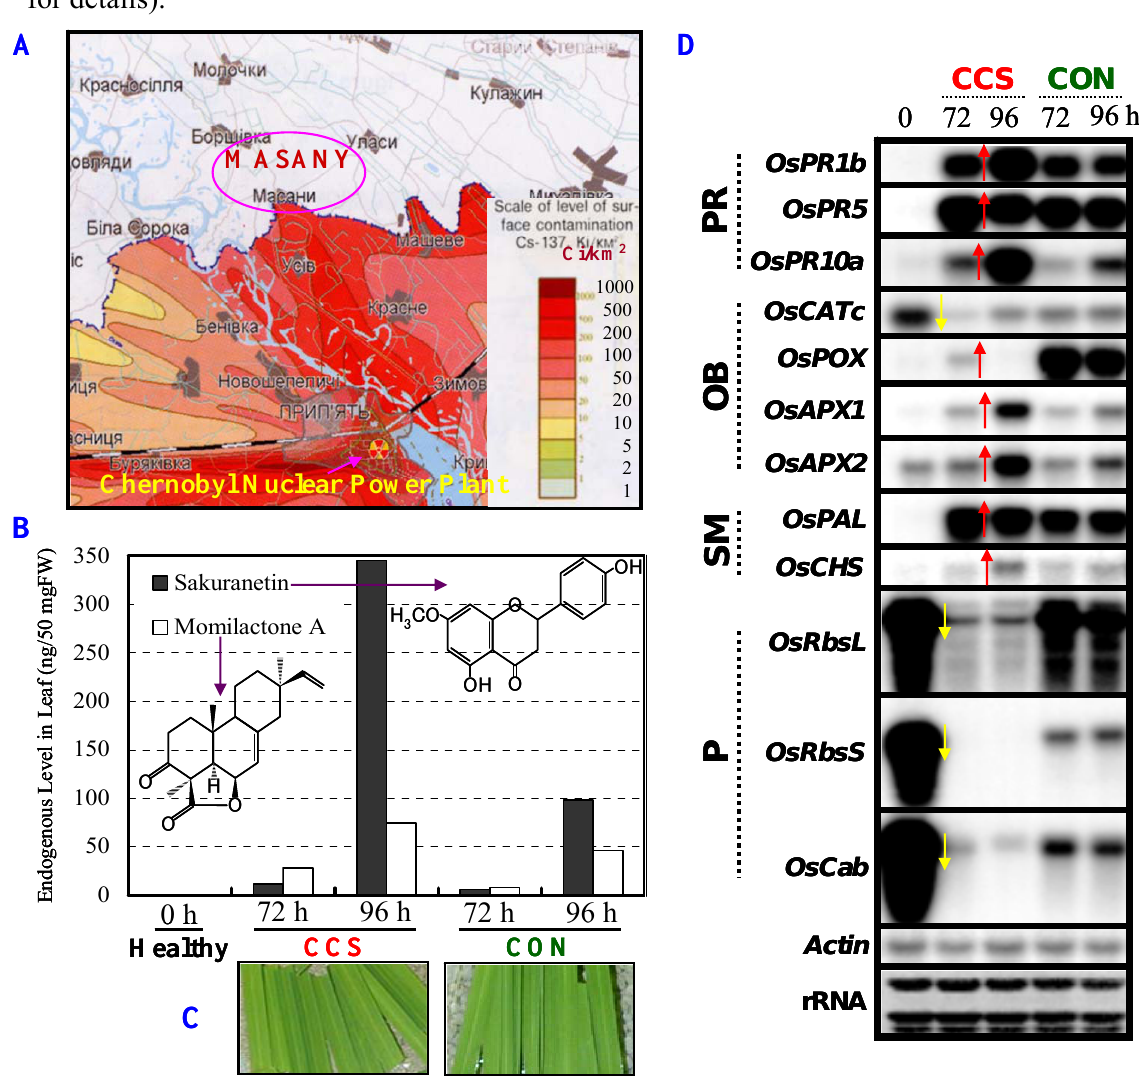
Figure 1. The effect of Contaminated Chernobyl Soil (CCS) on rice leaf biology. (A) Soil was collected during an on-site visit to Masany. (B) Levels of sakuranetin and momilactone A increase in leaves at 72 and 96 h after exposure (5.34  Gy/day) to CCS over control (CON), compared to non-detection in healthy leaves (0 h) at the start of the experiment. (C) Photograph (Digital Camera, Sony Cyber-shot 5.0 Megapixels) of representative leaf segments 96 h after exposure to CCS. (D) Northern blot analysis reveals changes in mRNA level of marker genes at 72 and 96 h using gene specific cDNA probes for rice genes: OsPR1b , OsPR5 and OsPR10a ; OsCATc , OsPOX and OsAPX1/2 ; OsPAL and OsCHS ;, OsRbsL , OsRbsS and OsCab . Leaf segments cut from the 3 rd /4 th leaves of two-week-old seedlings were used as the experimental material (see also Section 2.2 for